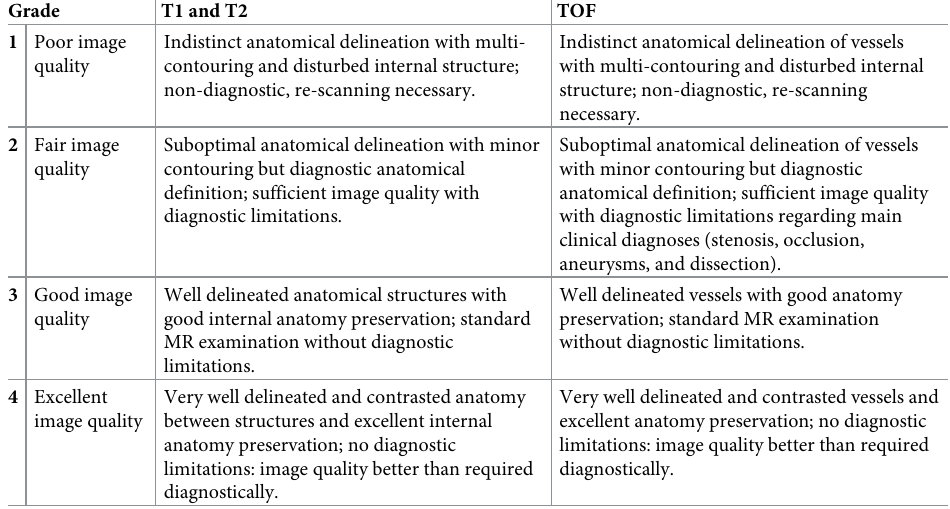
Table 1. Definition of grading scale used for assessment of image